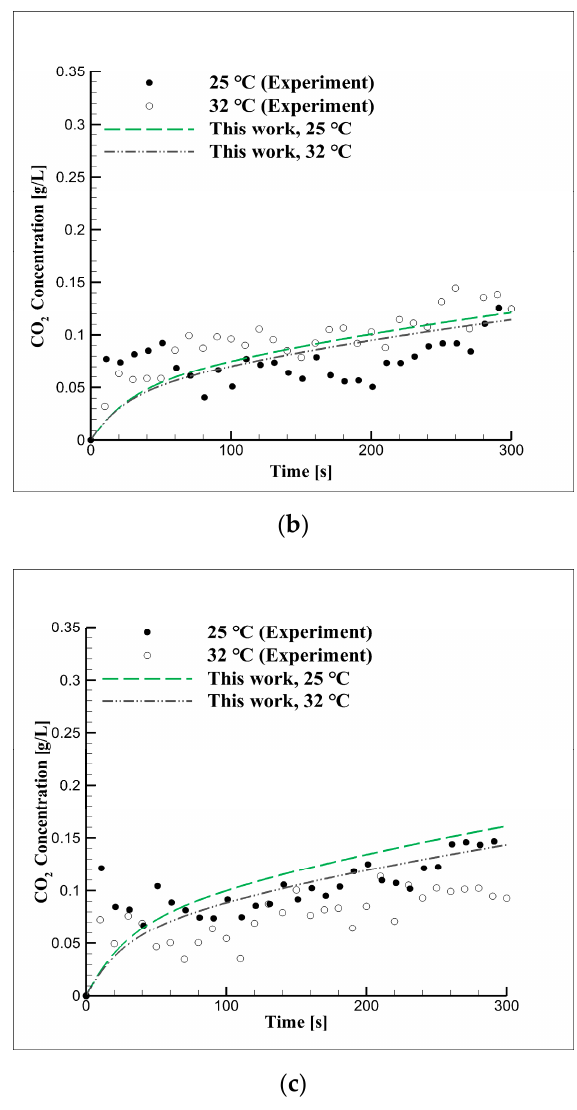
Figure 5. Short-term CO 2 concentration over time due to changes in equilibrium pressure and temperature in seawater at pressures of ( a ) 2, ( b ) 3, and ( c ) 5 bar.